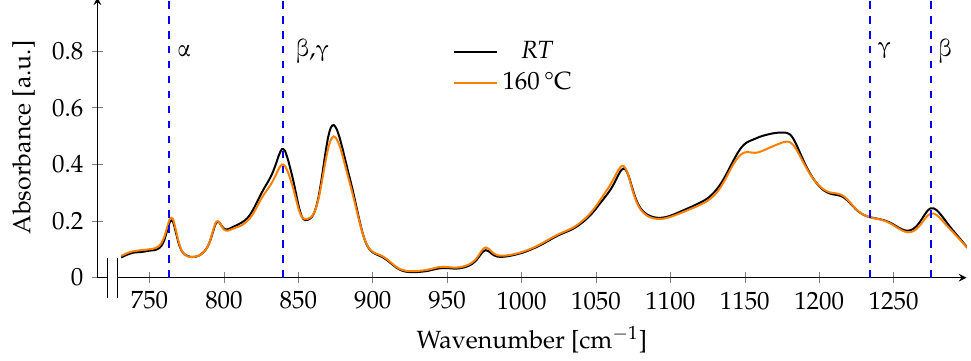
Figure 4. FTIR spectrum before and after annealing at 130°C. Dashed blue lines indicate the main absorption bands of the respective phases at A 763 , A 840 , A 1234 and A 1275 . After annealing at the highest temperature, the absorption band assignable to both electroactive phases shifts towards a peak at 833 cm − 1 , which is unique to the γ -phase. An absorption band at 1234 cm − 1 is apparent, which is also unique to the γ -phase, while the peak related to the β -phase decreases. The peak related to the α -phase also increases slightly (Figure 5). A distinction between the proportion of the β -phase and γ -phase is possible by calculating the peak-to-valley height ratio between the peak related to the γ -phase at 1234 and nearest valley at 1225 cm − 1 , as well as a comparison between the peak related to the β -phase at 1275 and the nearest valley at 1260 cm − 1 . Those height differences multiplied with the total fraction of the electroactive phase F EA are used for calculating the relative fraction of each phase [16]. Due to the poor manifestation of the β -phase absorption band, such comparison is not practicable in this case. However, the observations hint to a dominance of the γ -phase over the β -phase (Figure